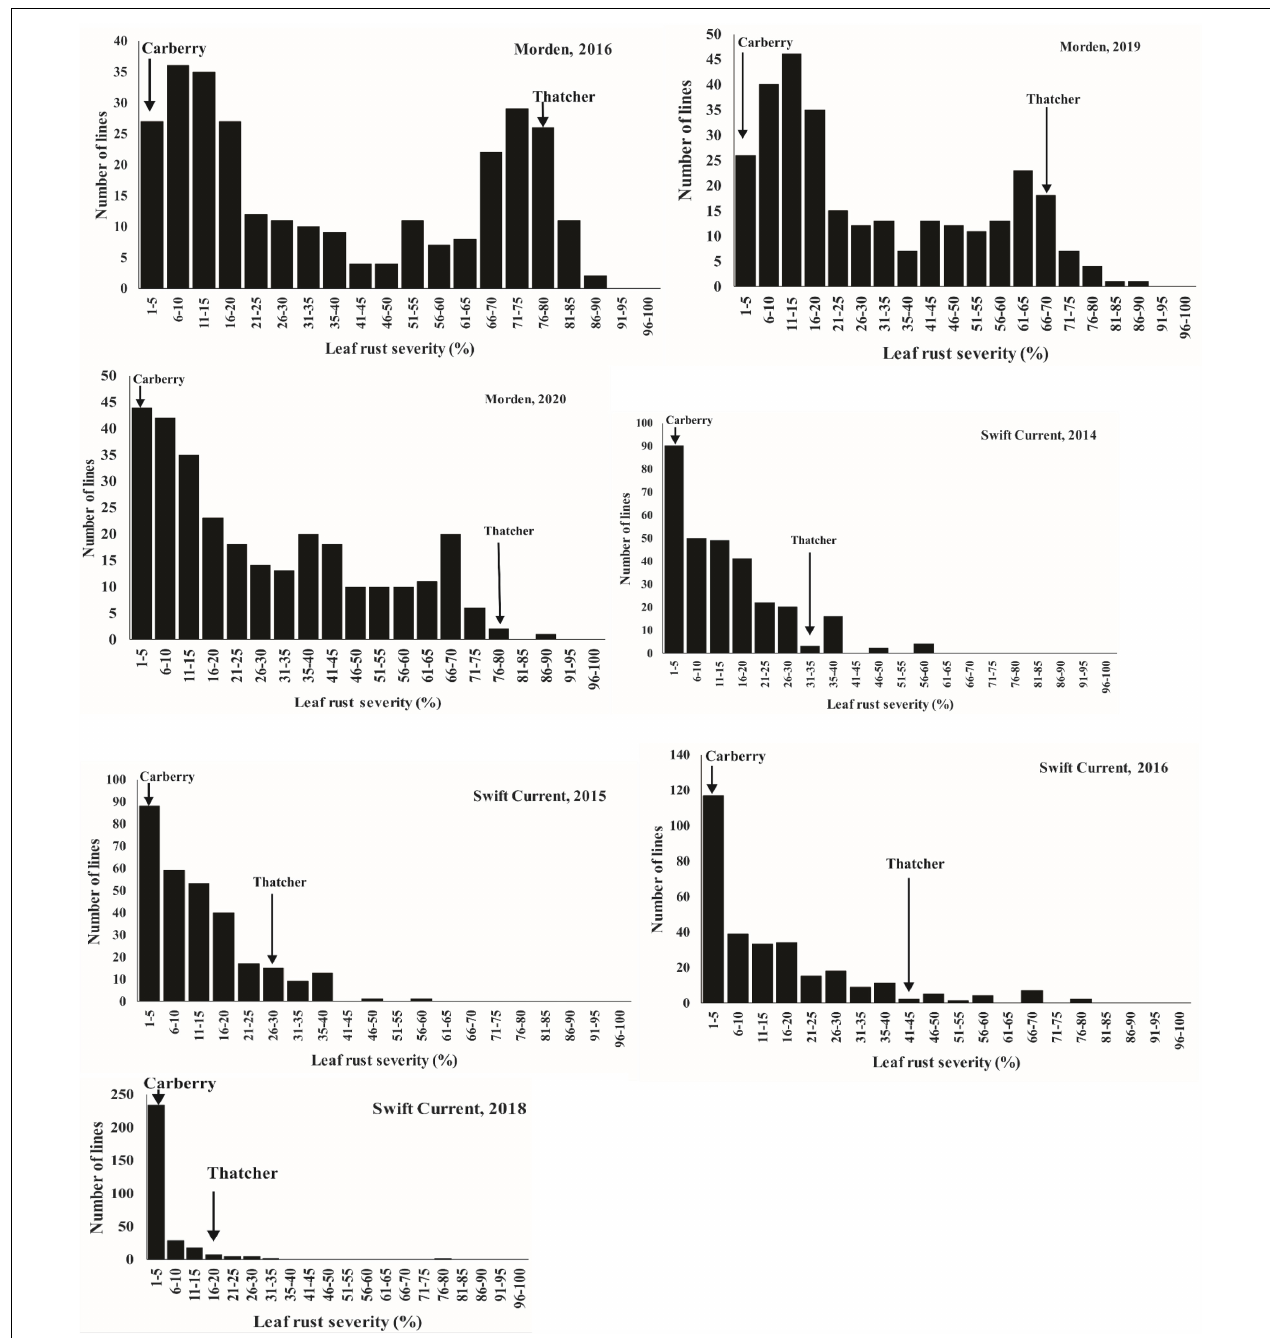
FIGURE 2 | Distributions of leaf rust severity for Carberry/Thatcher lines evaluated over multiple years in Morden, MB and Swift Current, SK locations. Arrows indicate the severity of the parents.